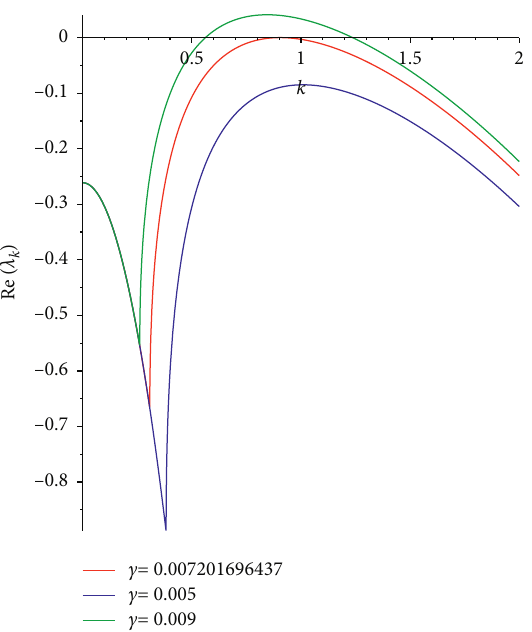
Figure 2: Dispersion relation of system (4), which shows the real part of eigenvalues λ